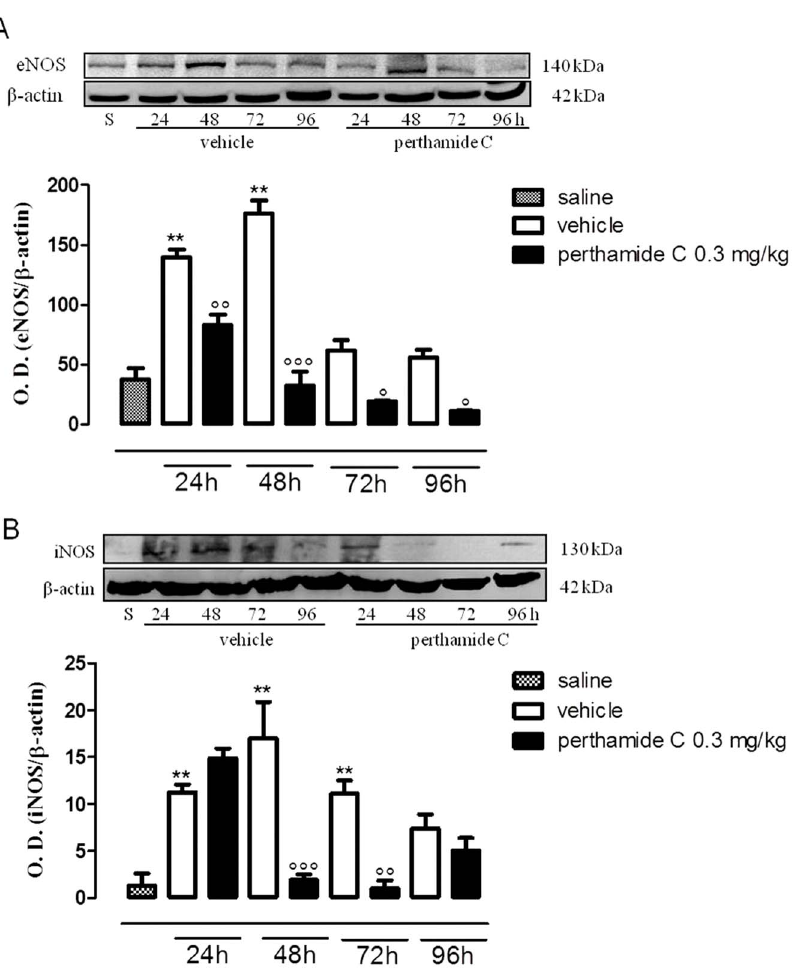
Figure 3. Western blot analysis of eNOS and iNOS in the late phase of the paw edema. Expression of eNOS (A) and iNOS (B) were evaluated in paws homogenates obtained from mice treated with perthamide C, vehicle or saline at 24, 48, 72, 96 h following l -carragenan injection. (n=4 paws for each treatment and time point) ** P , 0.01vs saline, u P , 0.05, uu P , 0.01, uuu P , 0.001 vs vehicle. Image is representative of three separate